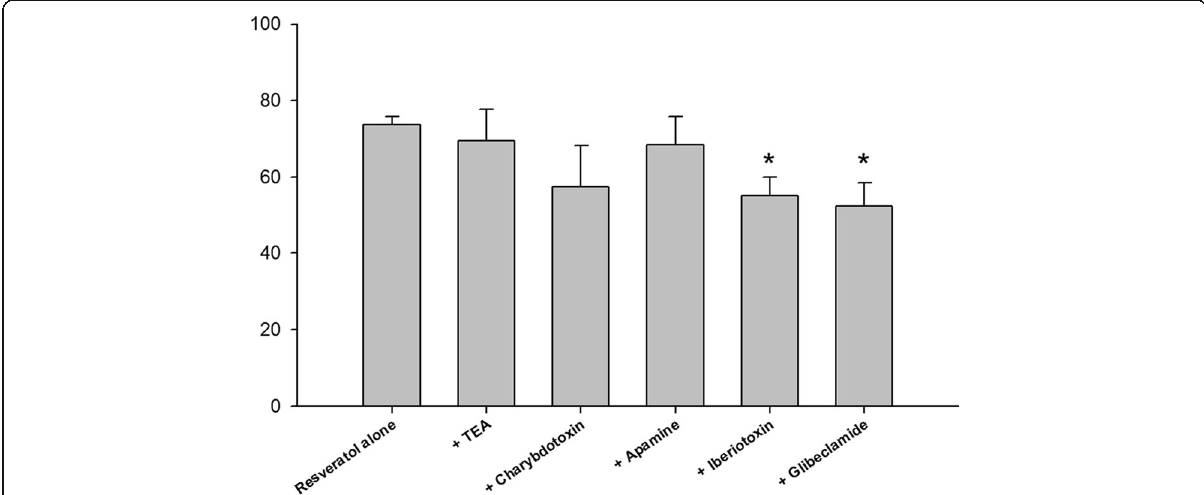
Fig. 5 The effects of tetraethylammonium (TEA), charybdotoxin, apamine, iberiotoxin, and glibenclamide on resveratrol-induced relaxation in the human gallbladder. TEA (1 mM), apamine (100 nM), and charybdotoxin (100 nM) had no significant effect on resveratrol-induced relaxation of human gallbladder muscle strips ( p > 0.05, n ≥ 4). In contrast, iberiotoxin (200 nM) and glibenclamide (10 μ M) significantly inhibited resveratrol-induced relaxation of human gallbladder muscle strips ( p < 0.05, n = 7). The vertical bars represent ± standard error of the mean